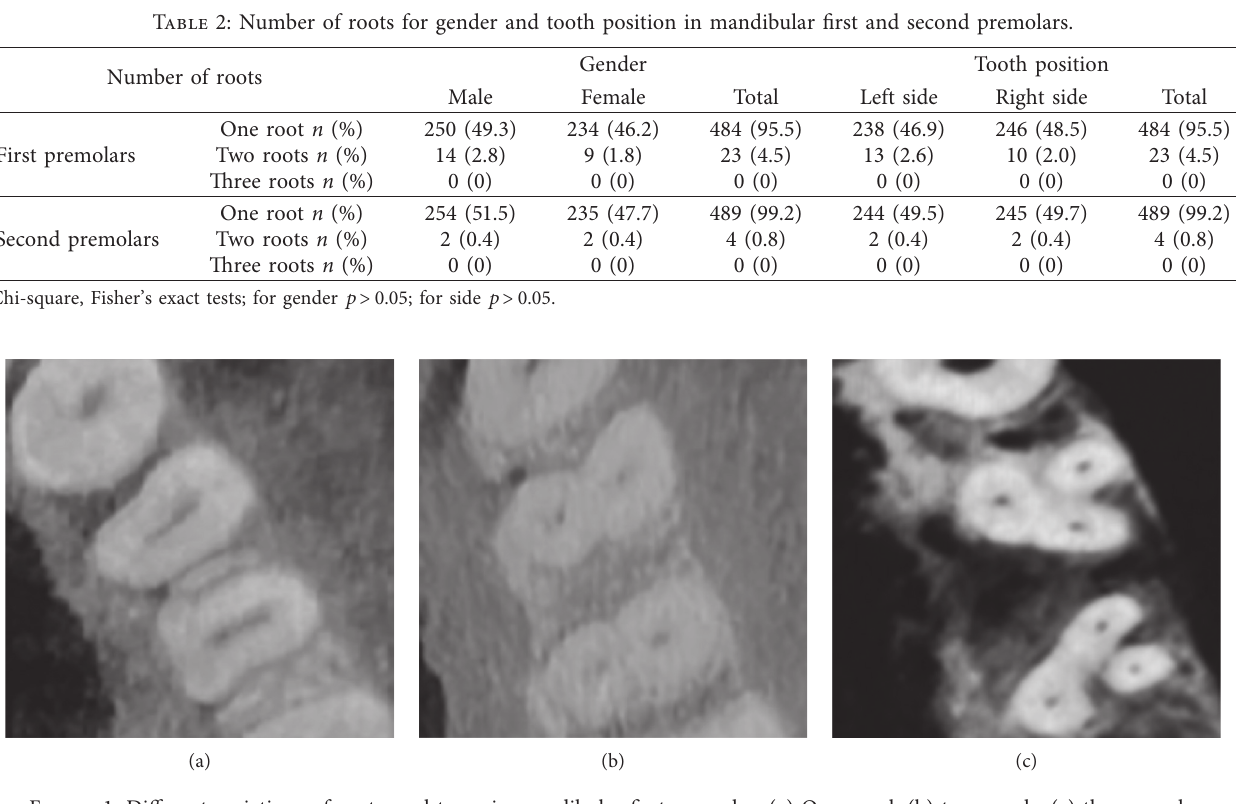
Figure 1: Different variations of root canal types in mandibular first premolar. (a) One canal; (b) two canals; (c) three canals.